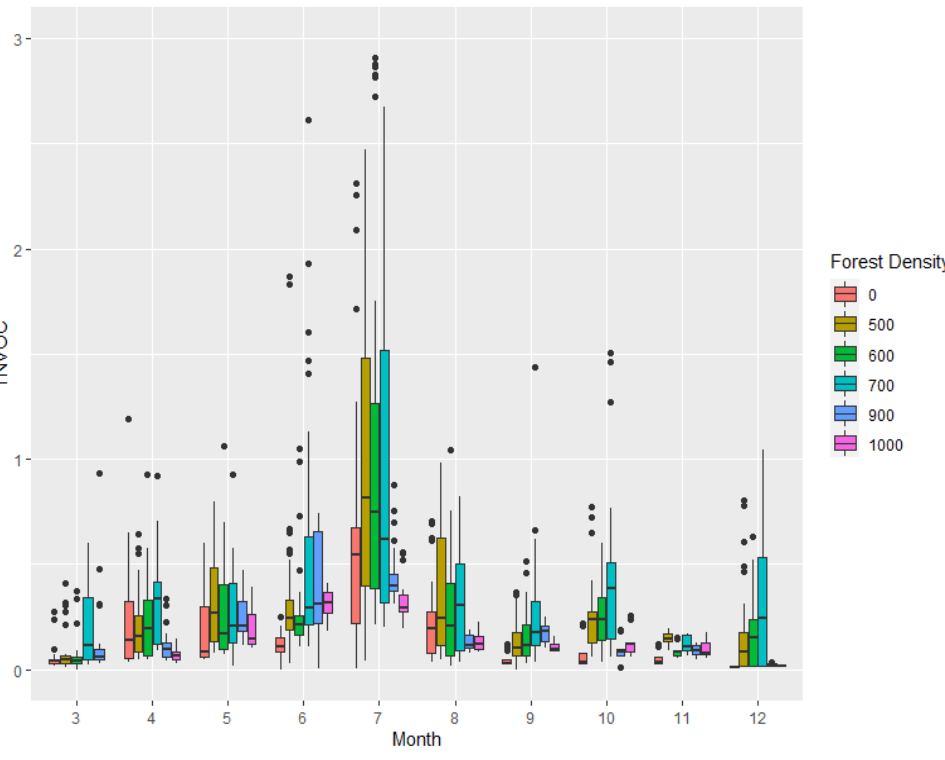
Figure 5. One hundred percent stacked bar charts of detected NVOCs by study sites.